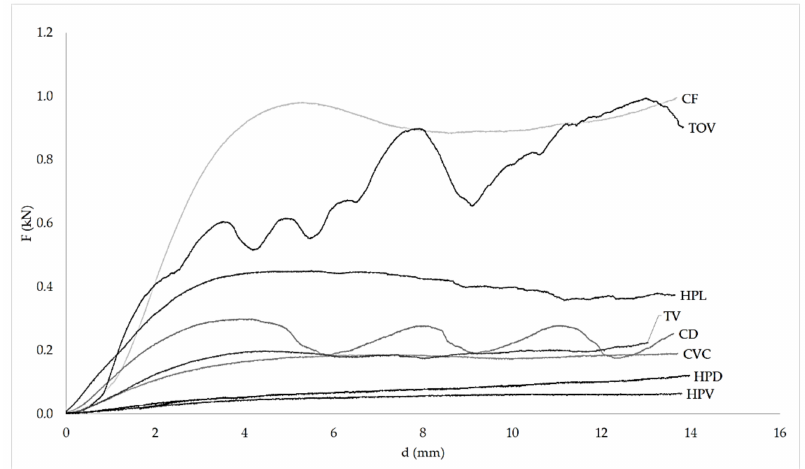
Figure 5. Force-displacement diagram for the eight ABS lattice structures. Please improve the quality of Figures 5–8 and try to keep the consistency in the plotting